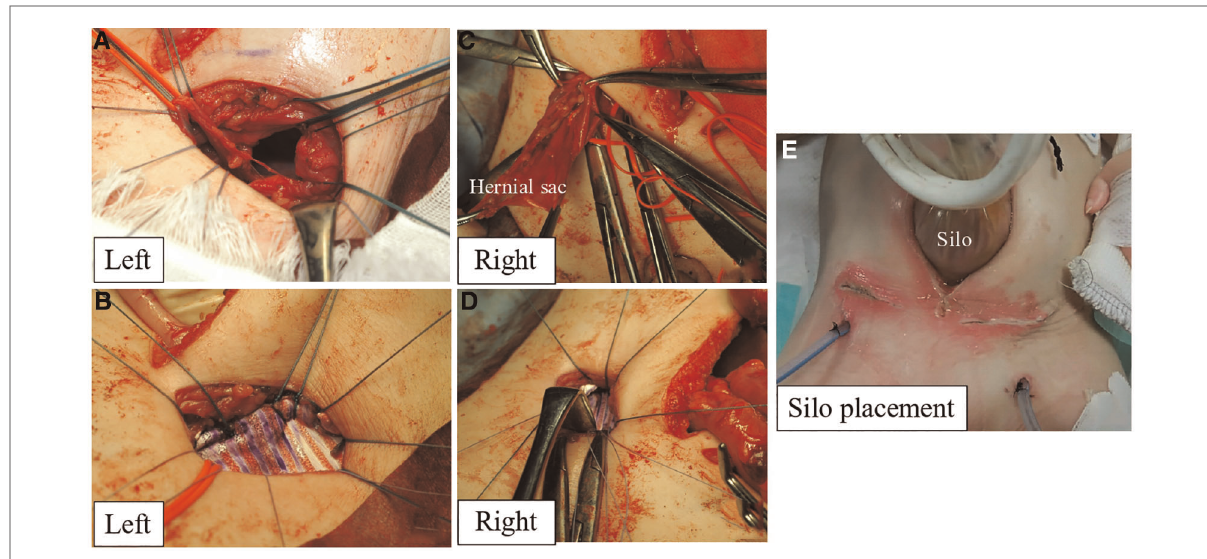
FIGURE 2 The left herniated ori fi ce ( A ) was closed with GORE ® DUALMESH ® biomaterial and non-absorbable threads by suturing with the pubic tubercle, transversus abdominis fascia, and iliopubic tract ( B ). The right herniated ori fi ce ( C ) was closed with GORE ® DUALMESH ® Biomaterial ( D ). After reducing prolapsed intestine into the abdominal cavity, the silo was placed at the midline incision ( E